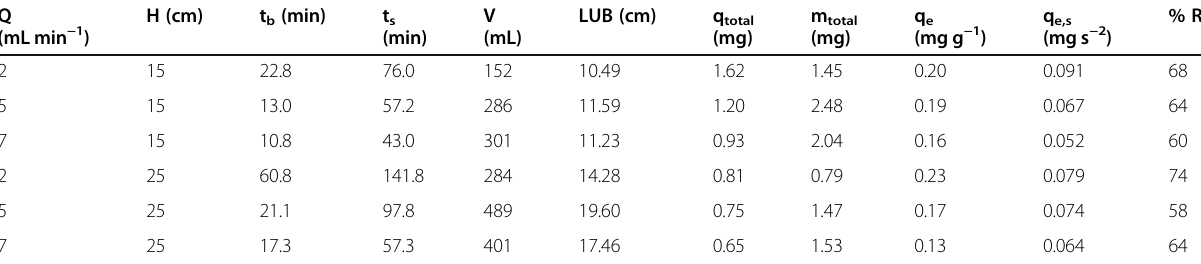
Table 5 Operating parameters of the adsorption column with sugarcane